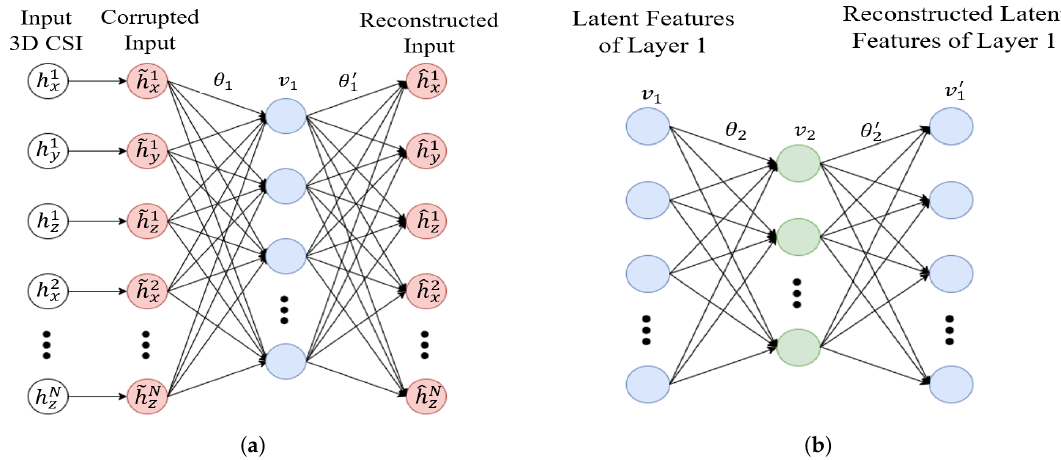
Figure 2. Depiction of the training process for the hidden layers of the denoising autoencoder on the input 3D CSI feature vectors for the first two stages. ( a ) Hidden Layer #1 ( b ) Hidden Layer